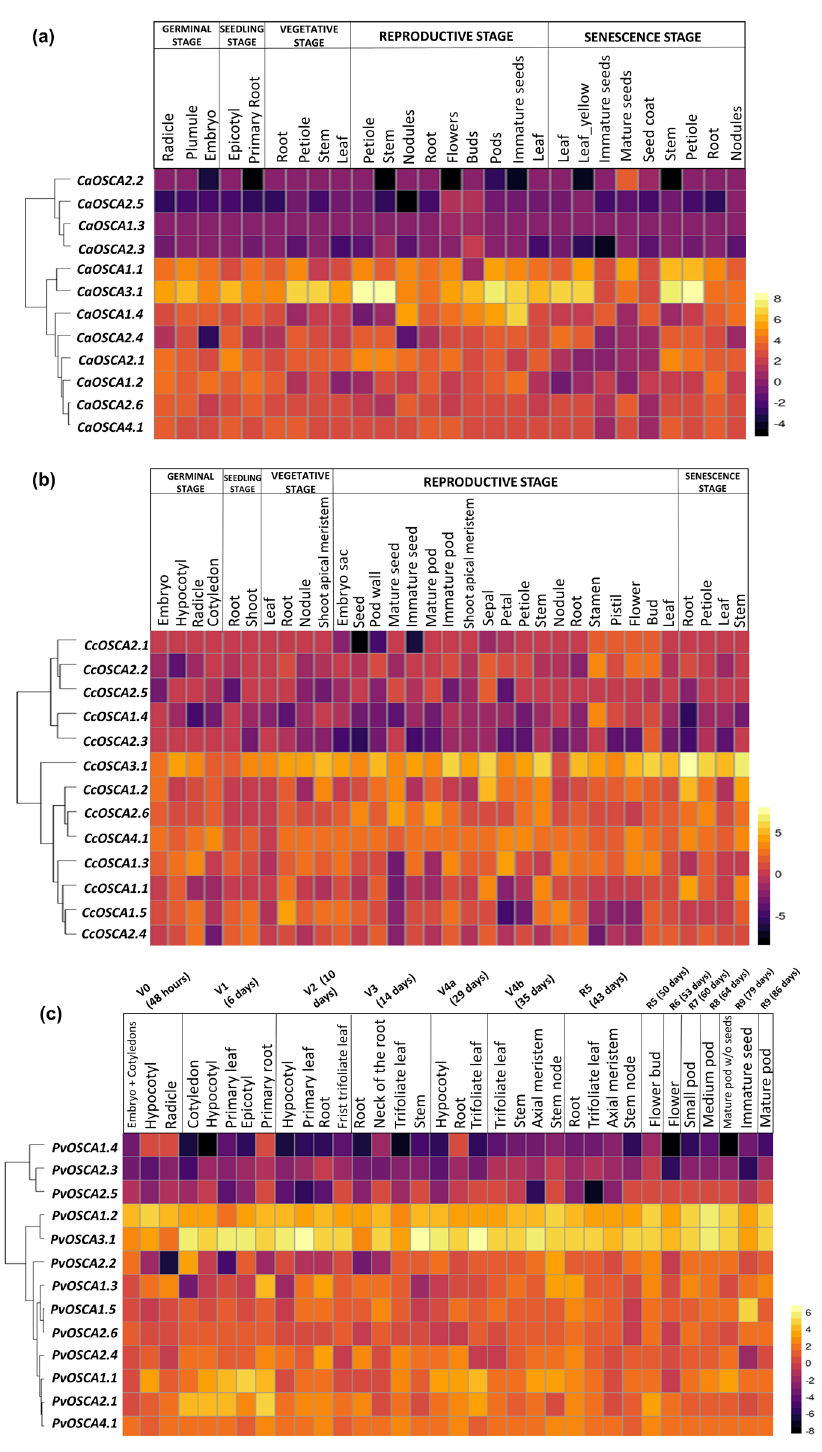
Figure 5. Gene expression analysis at different developmental stages. The genes are named on the left and different tissues/developmental stages are labelled at the top. The scale bar represents the normalised log2 FPKM values; ( a ) The heatmap represents the expression pattern of CaOSCA genes of Cicer arietinum at different developmental stages, such as germination, seedling, vegetative, reproduction and senescence; ( b ) Expression profiles of different CcOSCA genes in different developmental stages of Cajanus cajan . The heatmap represents the expression pattern of CcOSCA genes at developmental stages such as germination, seedling, vegetative, reproduction and senescence; ( c ) Expression profiles of different PvOSCA genes in different developmental stages of Phaseolus vulgaris . The heatmap represents the expression pattern of PvOSCA genes at different time periods in different tissues a different age of